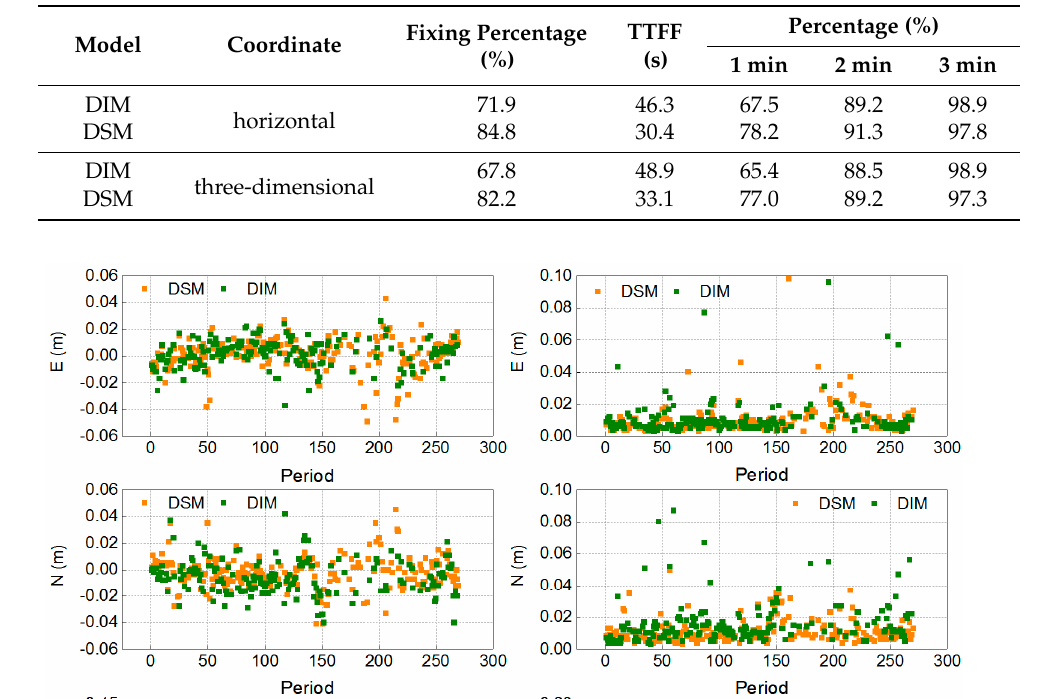
Table 4. Statistics of PPP-RTK simulating dynamic convergence results for large-scale networks.